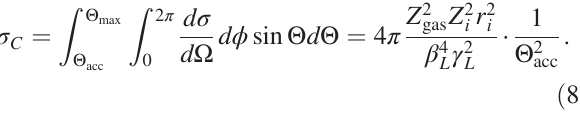
FIG. 3. Machine acceptance A ð β 0 Þ using (11) for a storage cell with diameter d ¼ 9 . 6 mm and length l ¼ 400 mm as a functionof β 0 at the target center. A reaches a maximum for